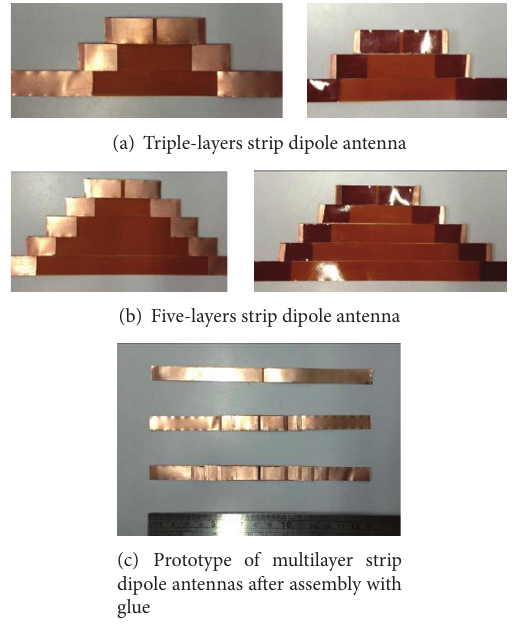
Figure 16: Prototype of multilayer strip dipole antennas.